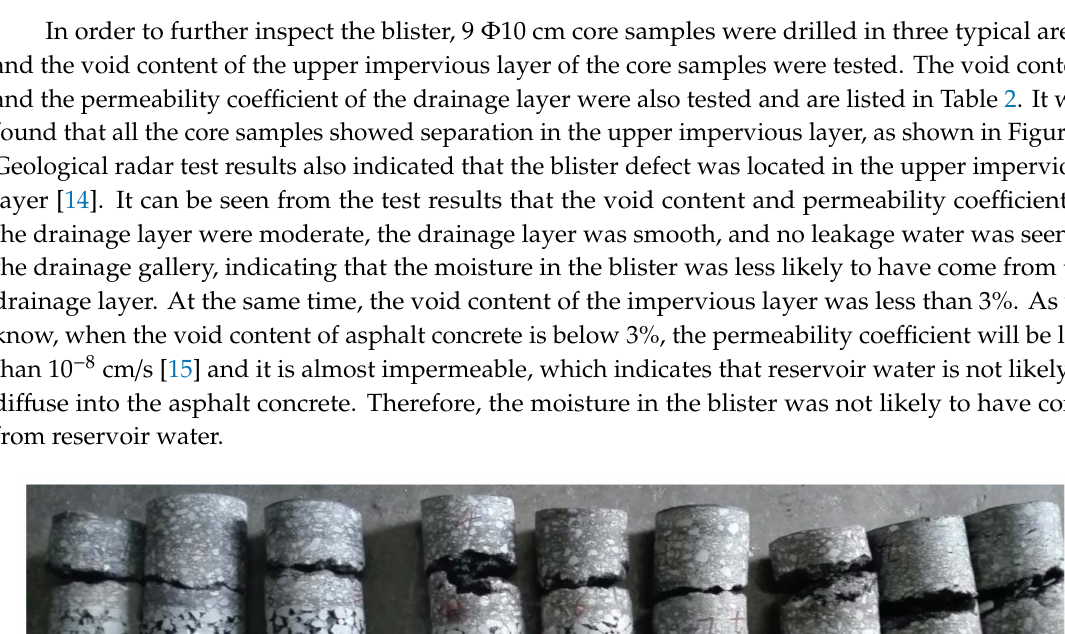
Figure 5. Core of the blister ( Φ 30 cm).